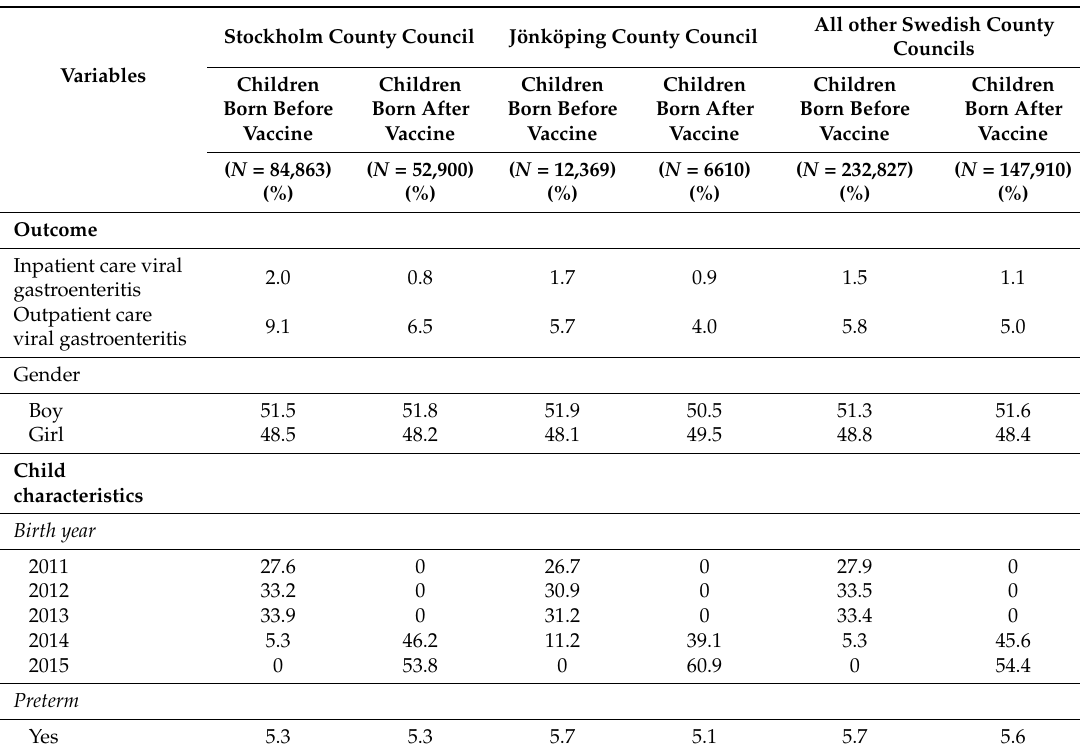
Table 1. Sociodemographic characteristics of the study